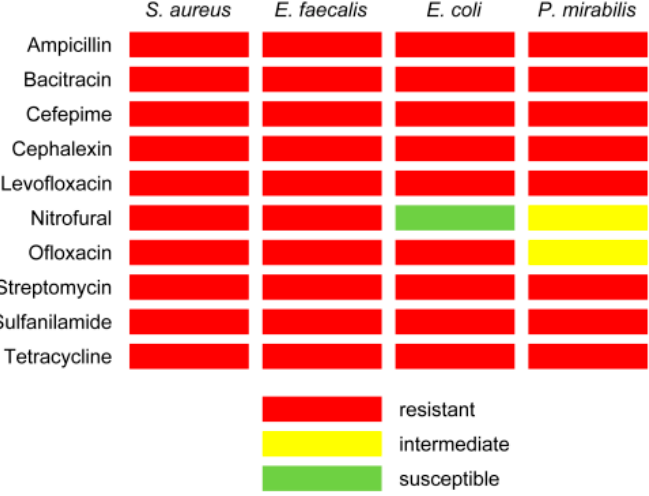
Figure 4. Results of antibiotic susceptibility